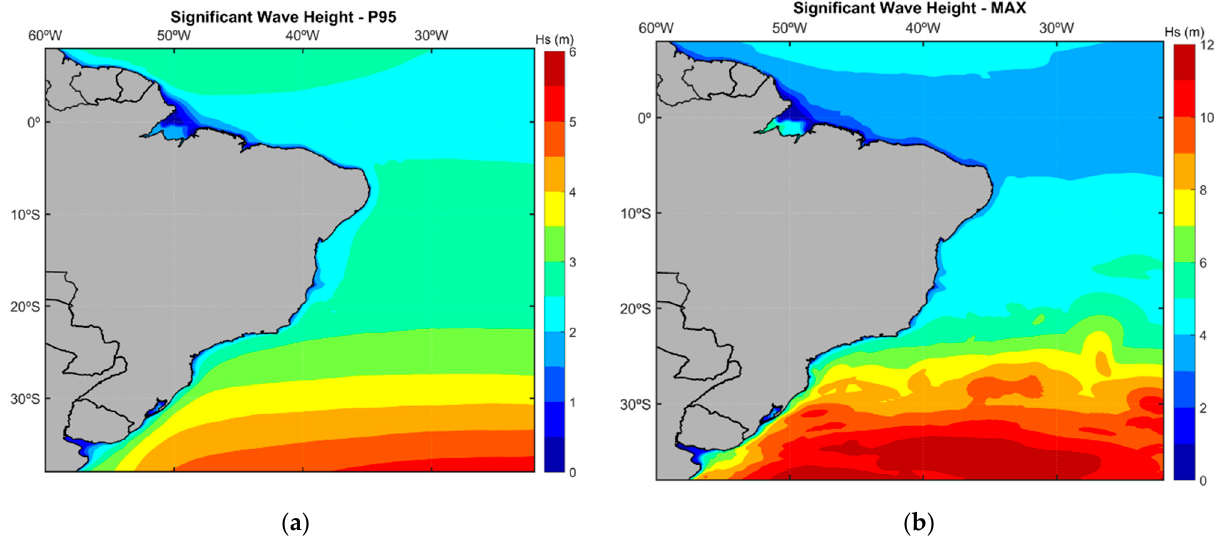
Figure 6. ( a ) Annual 95th percentile of 𝐻 (cid:3046) (m) for Brazil. ( b ) Annual maximum 𝐻 (cid:3046) (m) for Brazil.